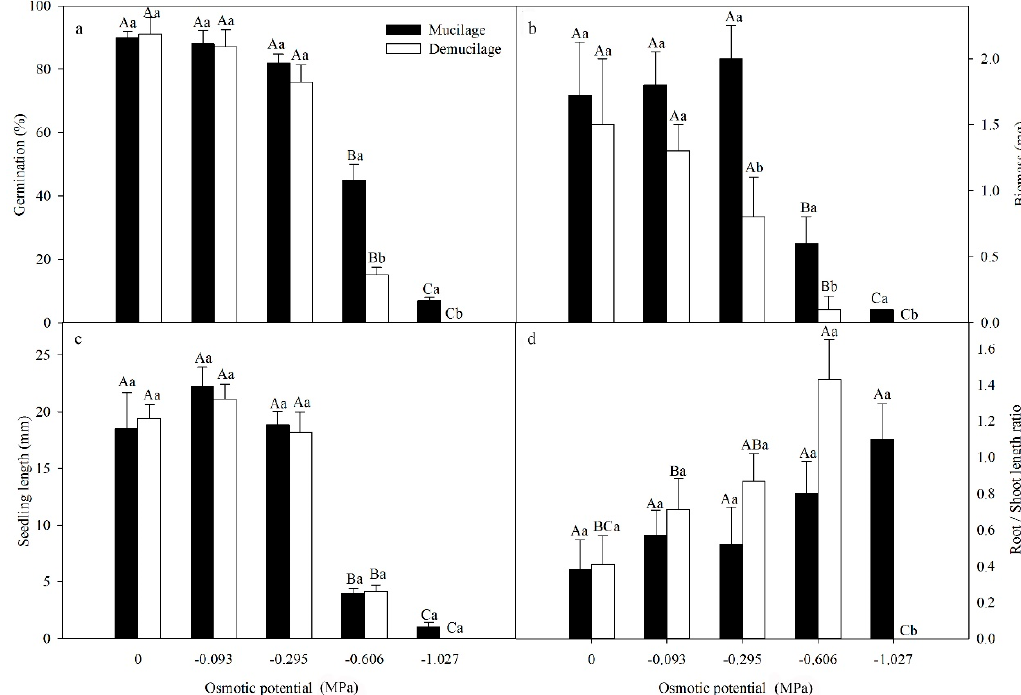
Figure 4. Mean (±SE) germination percentages at 30 days ( a ) and biomass ( b ), length ( c ) and root/shoot length ratio ( d ) of seedlings at 15 days of Lepidium apetalum . Seeds either contained mucilage or did not (demucilage) and both seed types were incubated in the different osmotic potentials in light at 20 °C. The different uppercase letters indicate significant differences among osmotic potentials and the different lowercase letters significant differences between mucilaged and demucilaged seeds within each osmotic potential (5% level).